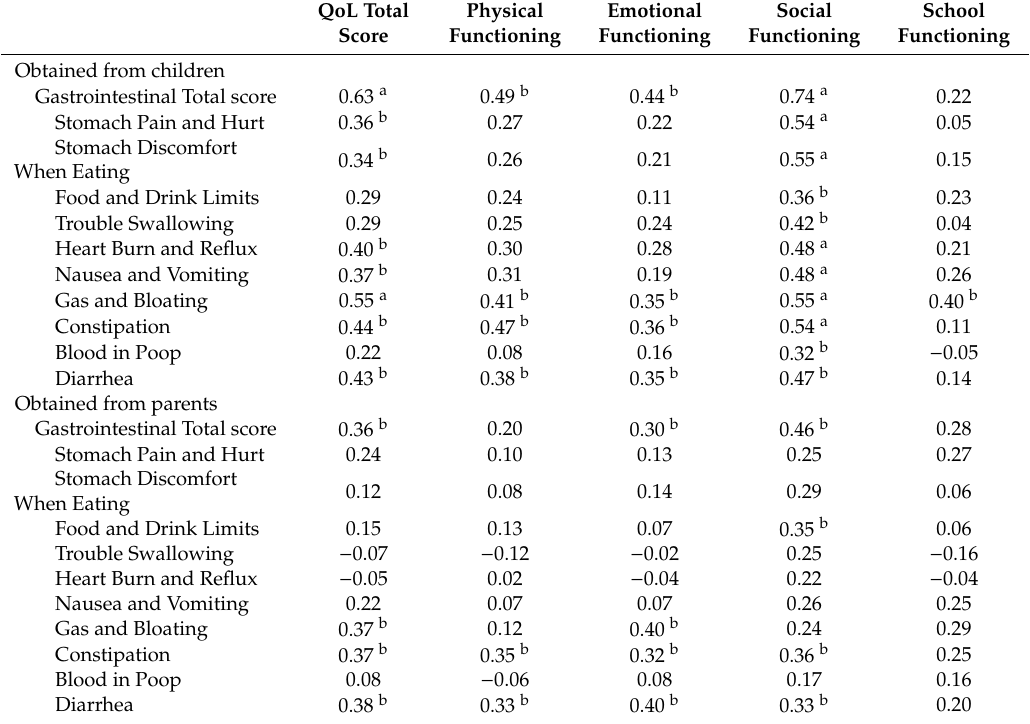
Correlations between PedsQL TM -Gastrointestinal symptoms scales 3.0 scores